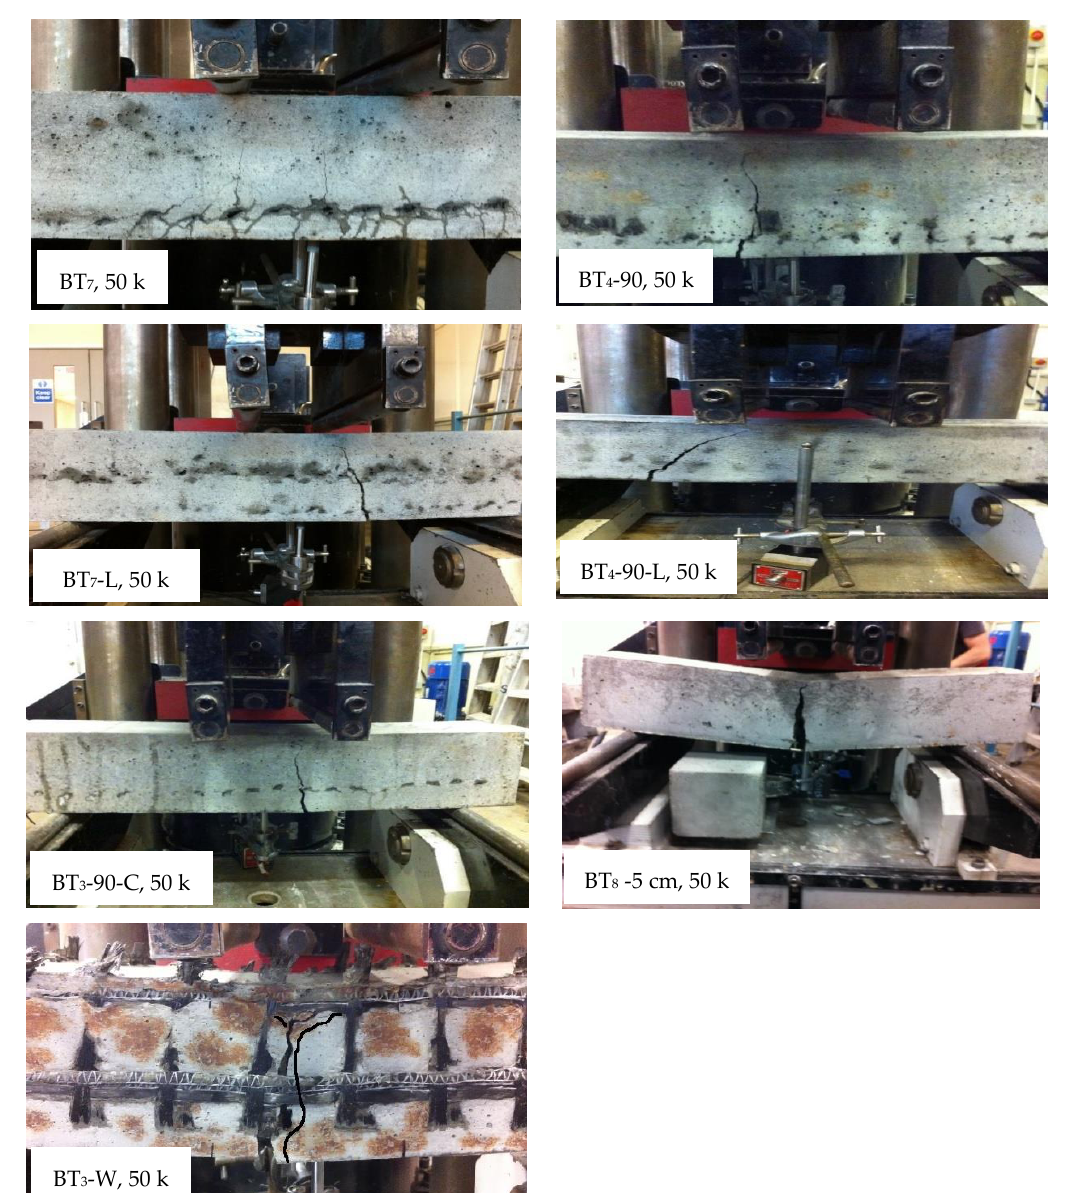
Figure 14. Cracks ’ pattern of beams reinforced by different bi-axial textiles. Figure 14. Cracks’ pattern of beams reinforced by different bi-axial